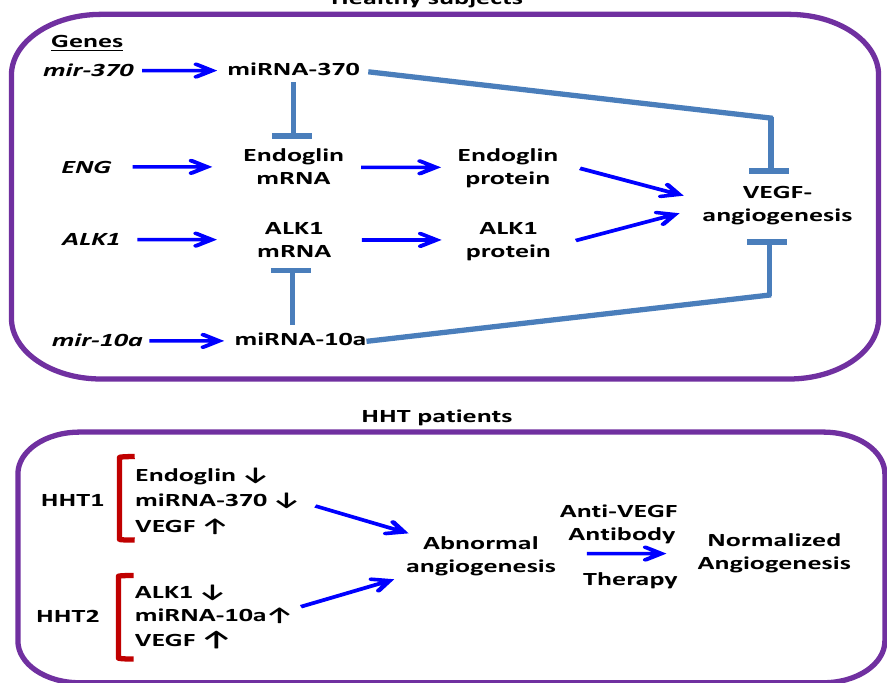
Figure 3. Hypothetical model for the involvement of miRNA-370 and miRNA-10a in HHT. Top, in healthy subjects, basal levels of miRNA-370 and miRNA-10a are predicted to target endoglin, ALK1, as well as the VEGF/VEGFR pathway, thus regulating angiogenesis. Bottom, in HHT patients, heterozygous mutations lead to a deficient expression of endoglin (HHT1) or ALK1 (HHT2), associated with increased levels of VEGF and the dysregulated expression of miRNA-370 and miRNA-10a, resulting in abnormal angiogenesis. Treatment with antibodies to VEGF (bevacizumab) contributes to angiogenesis normalization. ALK1: activin receptor-like kinase 1; VEGF: vascular endothelial growth factor; VEGFR: VEGF receptors.